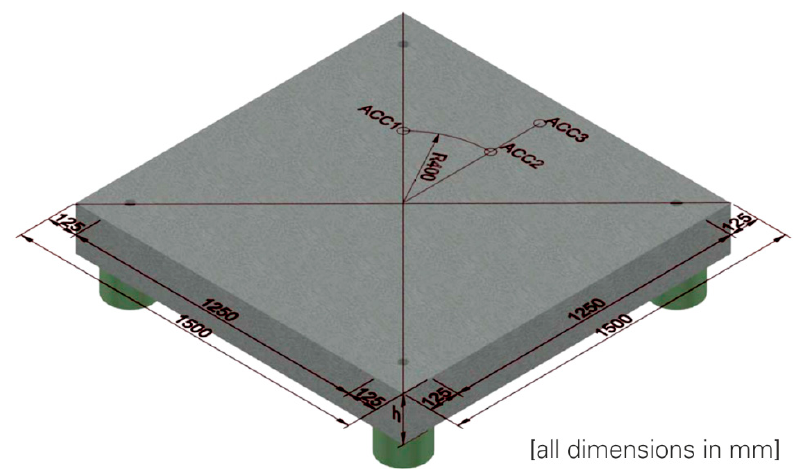
Figure 4. Schematic illustration of the support conditions and positioning of the acceleration sensors; Hering [17].